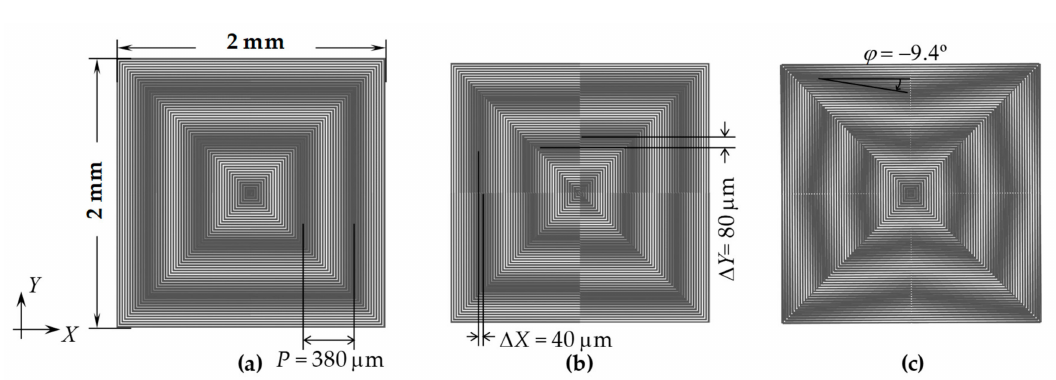
Figure 4. Moir é fringe patterns with various misalignments as examples: ( a ) ∆ x = ∆ y = 0; ( b ) ∆ x